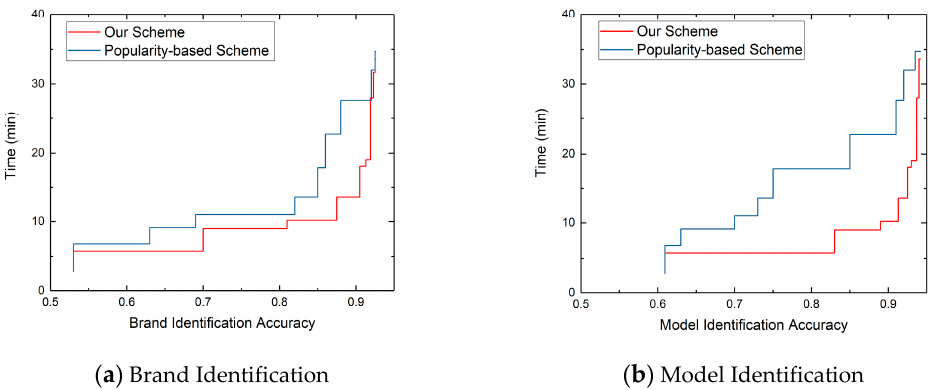
Figure 8. The relationship between identification accuracy and identification time. Sensors 2020 , 20 , x FOR PEER REVIEW